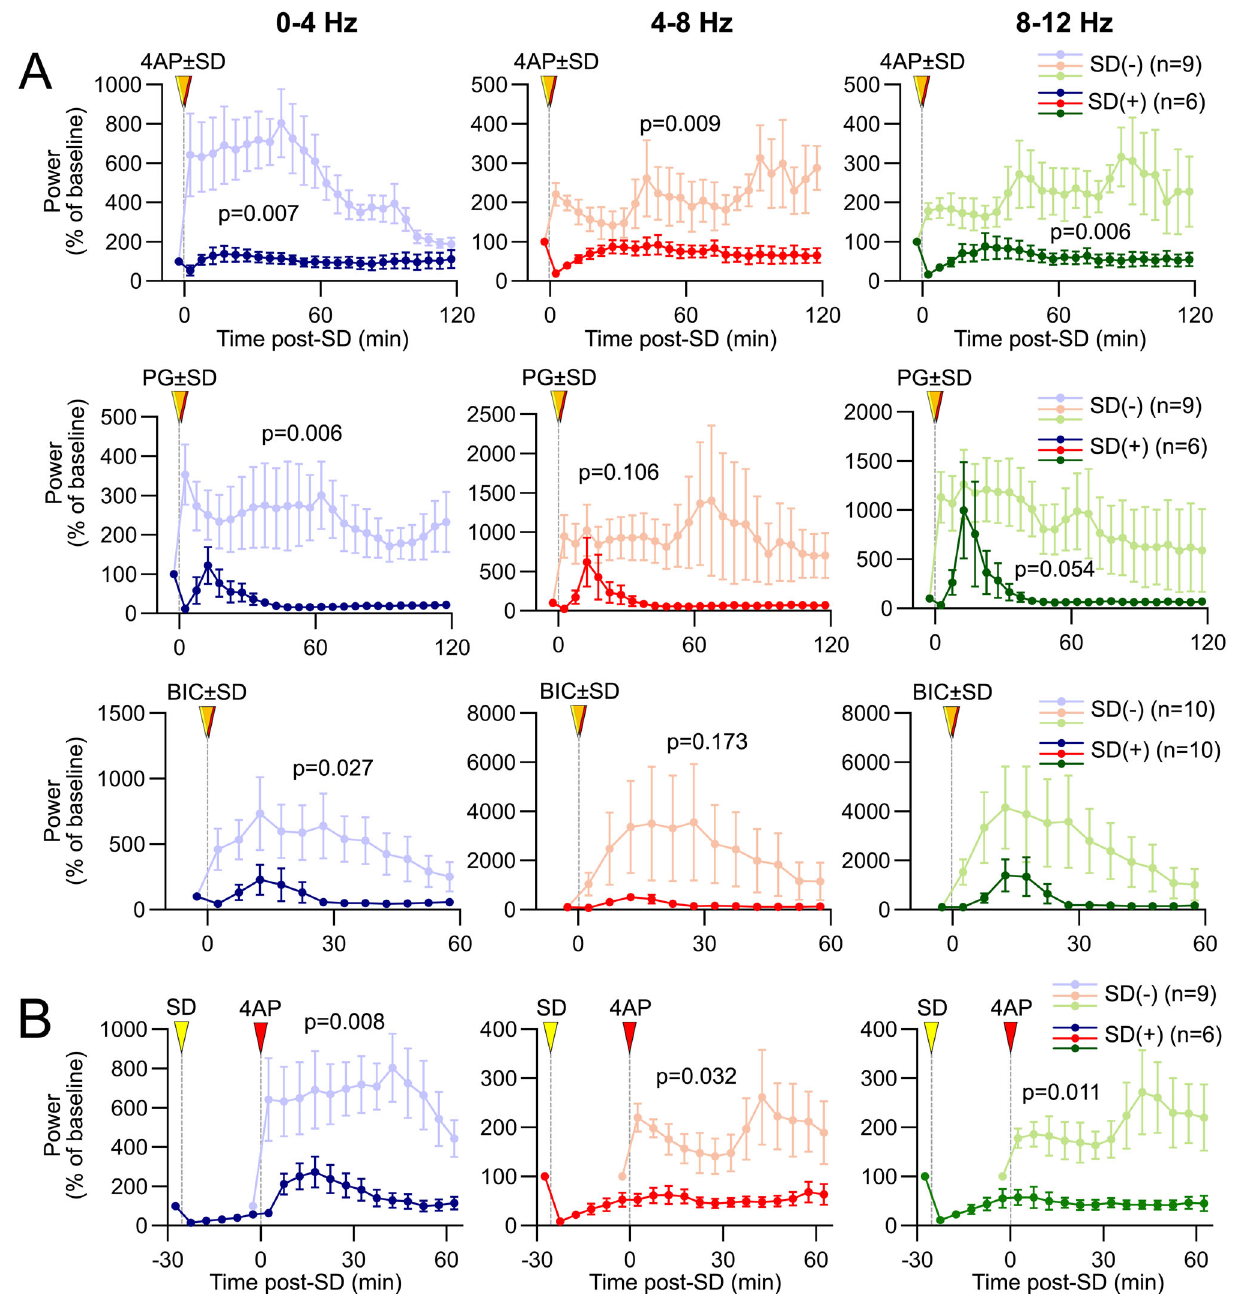
Fig. 6 Pre-treatment with SD strongly inhibits the emergence of seizure activity. A Average ECoG power time course graphs (5-min bins) expressed as % of baseline ( − 5 min) show that an SD induced (yellow arrowheads) 5 min before 4AP, PG or BIC application (red arrowheads) signi fi cantly diminished seizure intensity (bold curves) compared with controls without an SD (faint curves). B An SD induced 30 min before 4AP application still signi fi cantly suppressed subsequent seizure activity for at least 90 min. Data are from the drug application site (E1, Supplementary Fig. 1B). Each frequency band is shown separately. Exact p values are shown for SD ( − ) vs. SD ( + ), using two-way repeated-measures